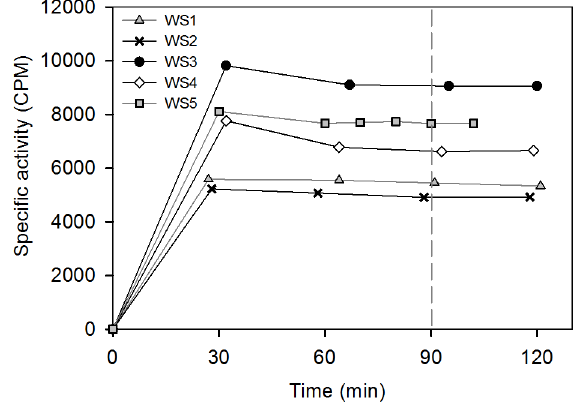
Figure 1. HTO equilibration curve for five Weddell seals showing plateau by 90 min.